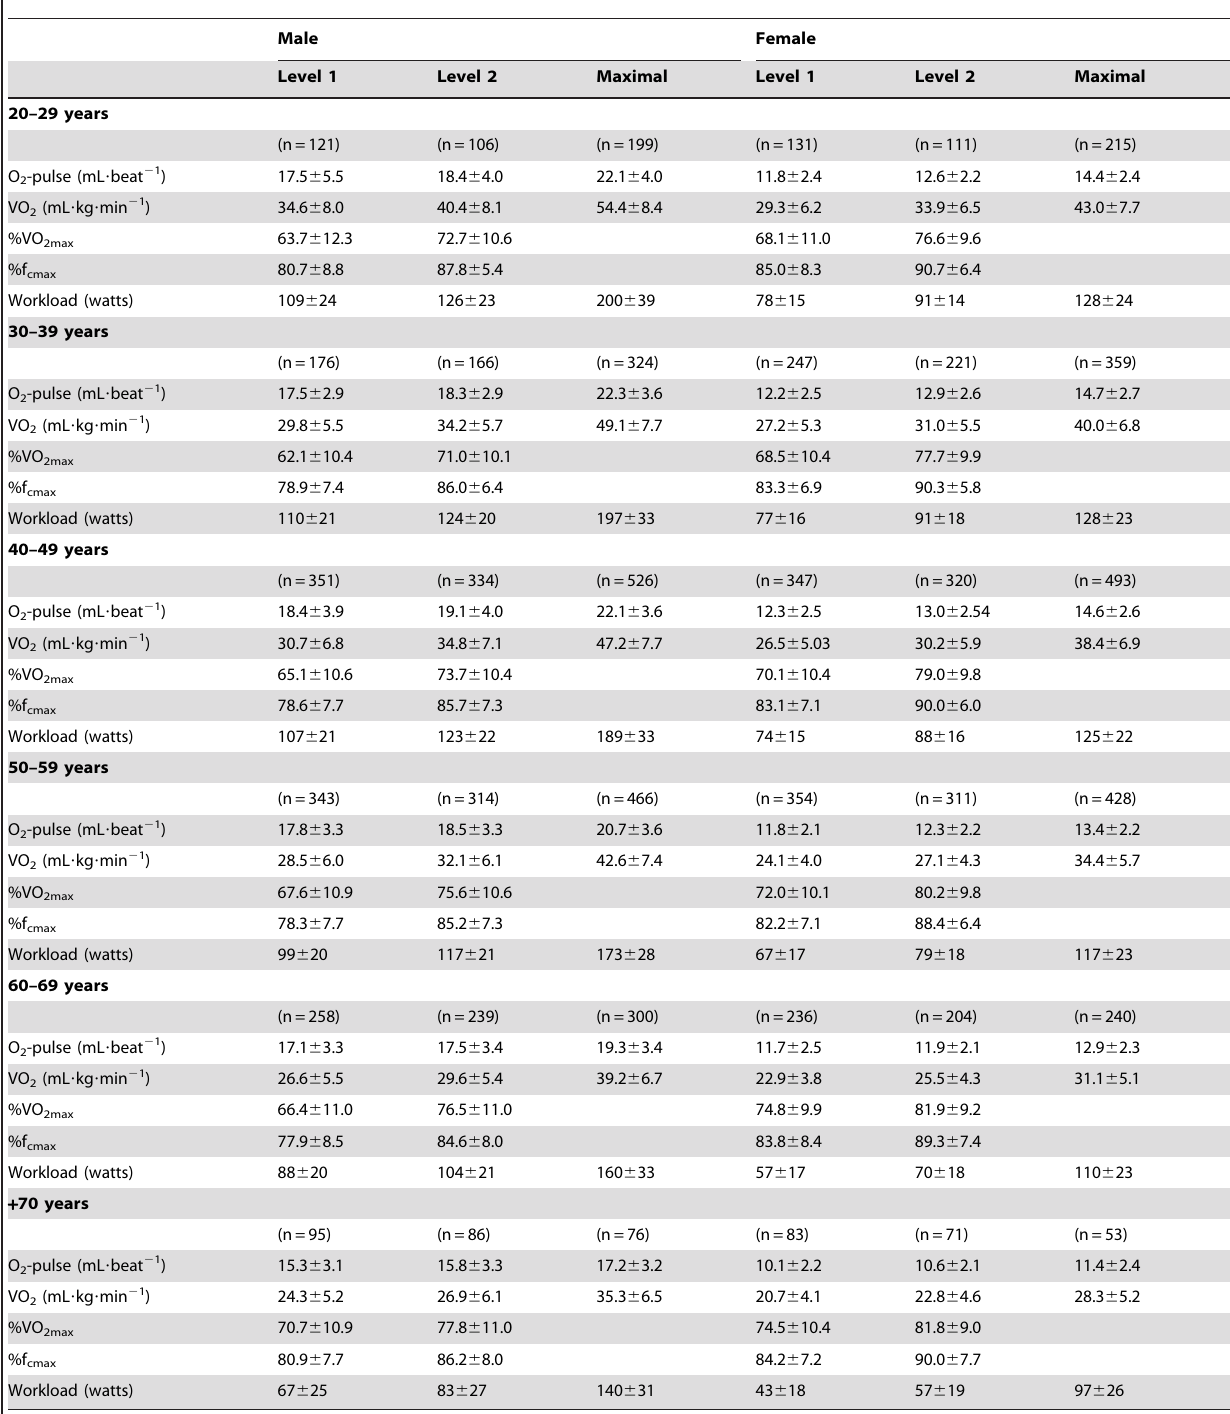
Table 3. O 2 -pulse in the HUNT 3 Fitness study stratified by intensity levels, sex and age groups.